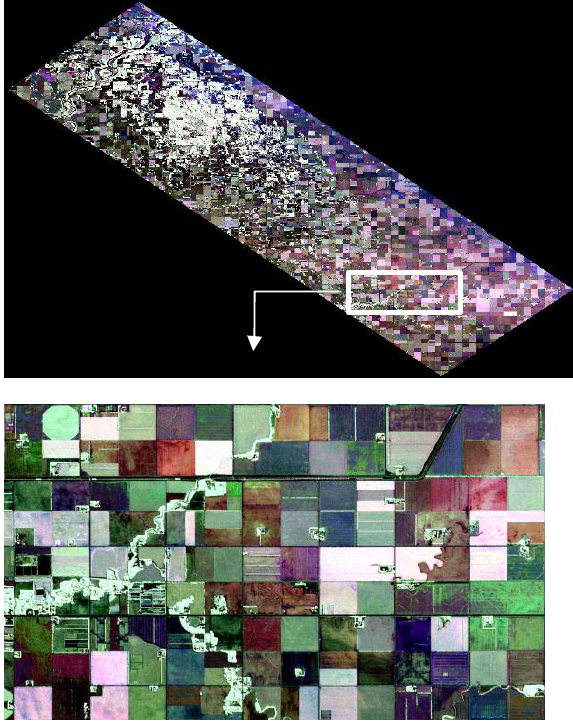
Figure 1 RGB color composite of